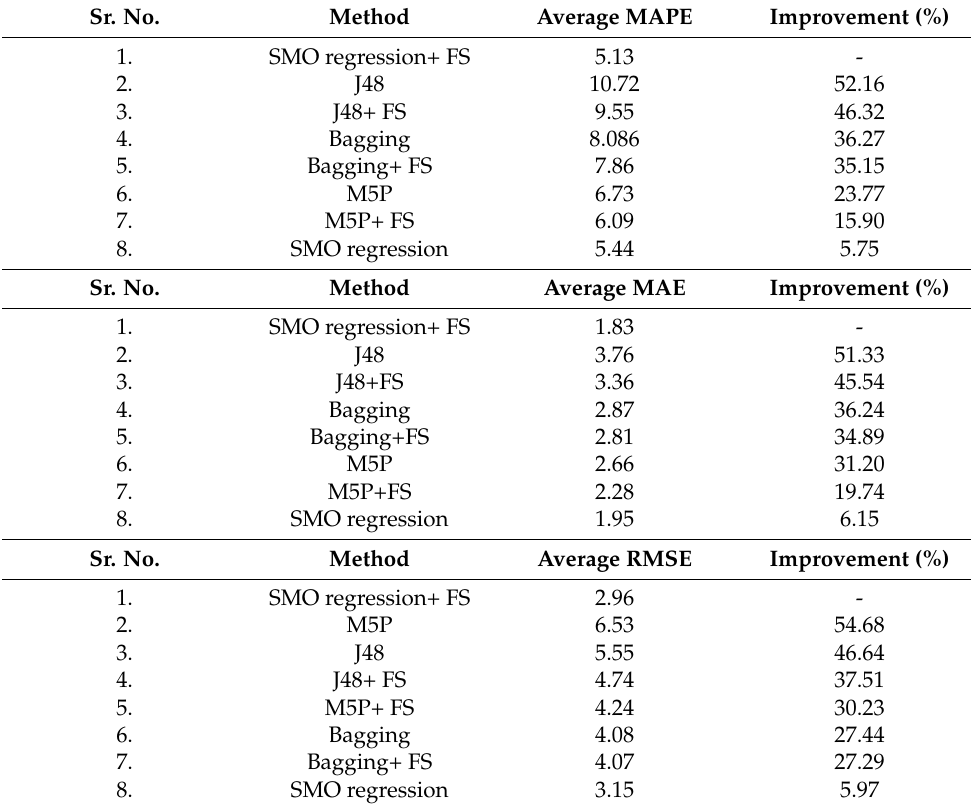
Table 5. Improvement of error measures using SMO regression+ FS over other approaches. Sr. No.